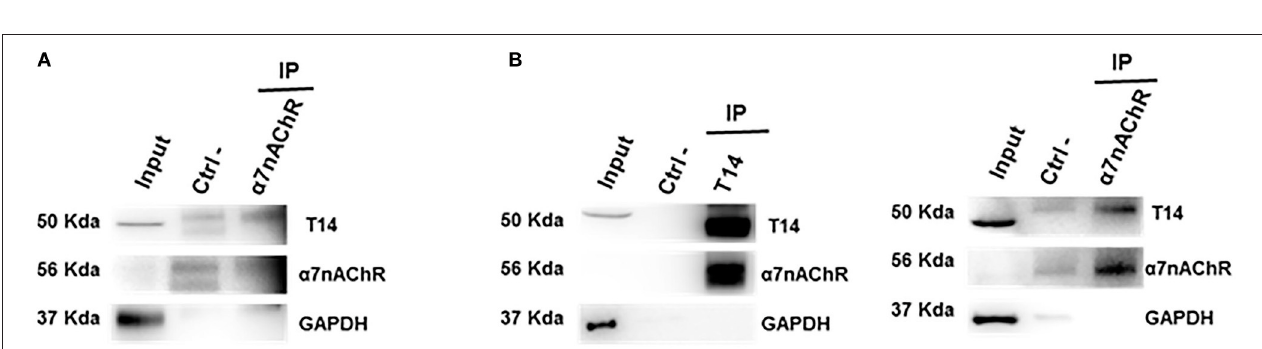
FIGURE 1 | Coronal brain sections used in this study. They include the rostral (slice 1), the intermediate (slice 2), and the caudal (slice 3) portion of the basal forebrain (BF) (blue dotted line). Each slice is divided in two complementary halves (white vertical line) and treated with different conditions (a, b).